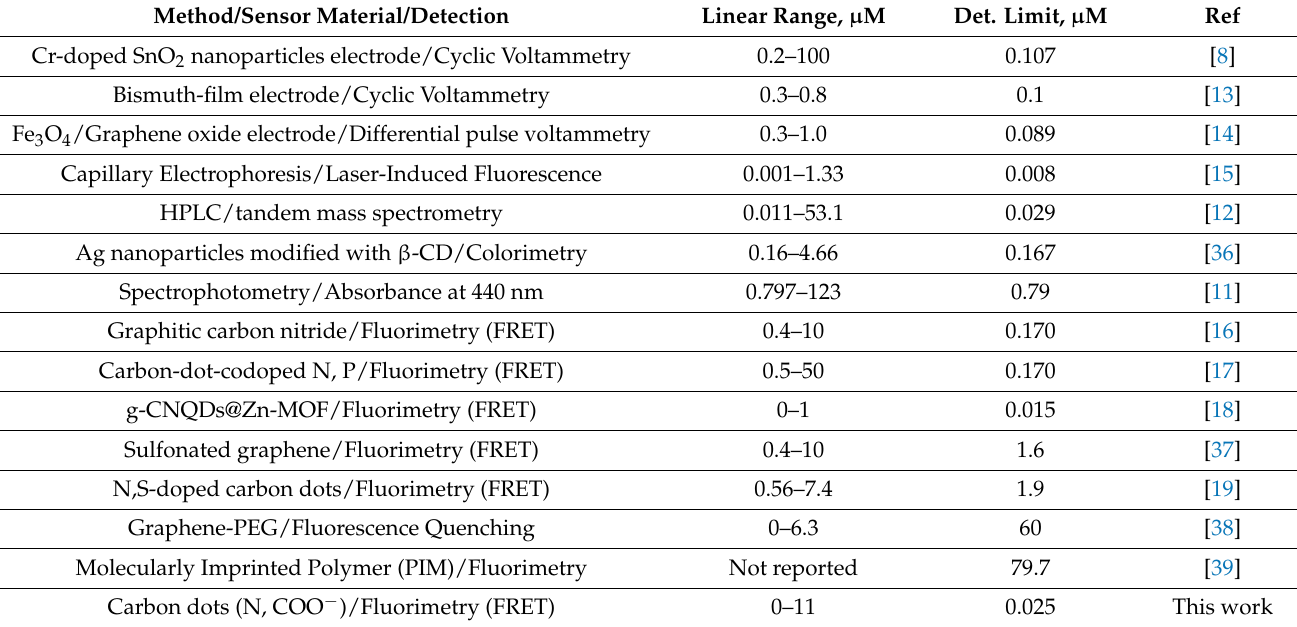
Figure 6. ( A ) Fluorescence emission ratio (I 521 /I 441 ) of CDs–potential interferences and ( B ) fluorescence emission ratio (I 521 /I 441 ) of CDs–RF–potential interferences (molar ratio of RF:interference = 1:1). PBS was used throughout (pH = 7.4). Table 2. Comparison of different methods for RF